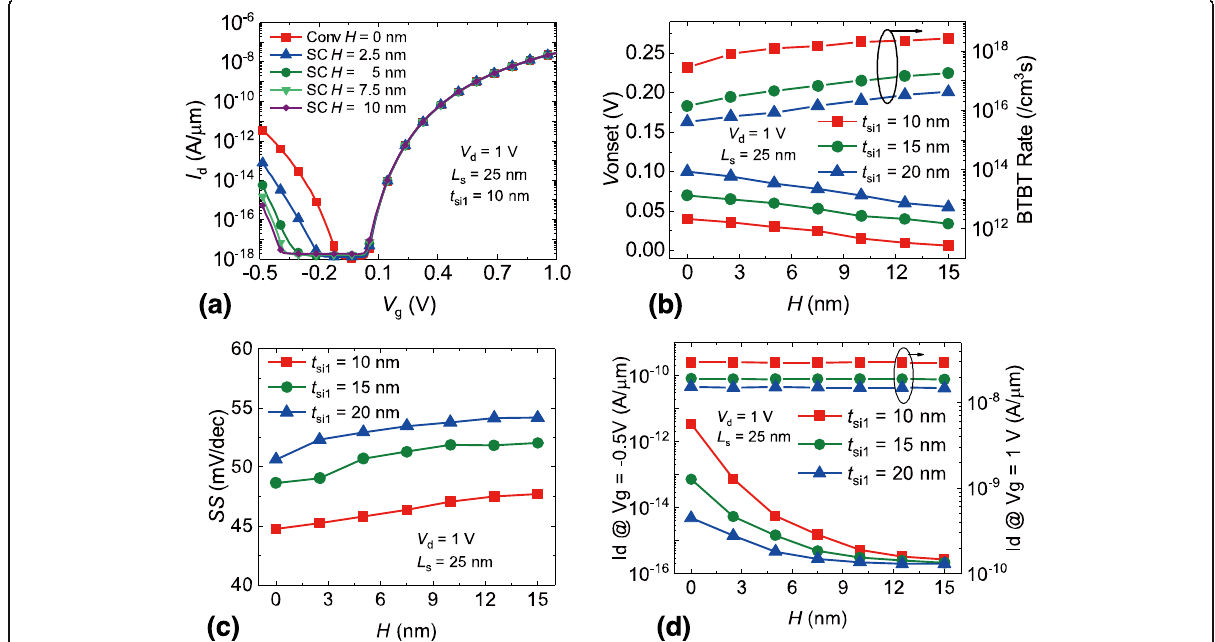
Fig. 5 The impacts of H on the a transfer curves, b V onset and BTBT rate, c average SS , and d drain current in on/ambipolar state, H is the height of the step and H = 0 nm represents the conventional DG TFET